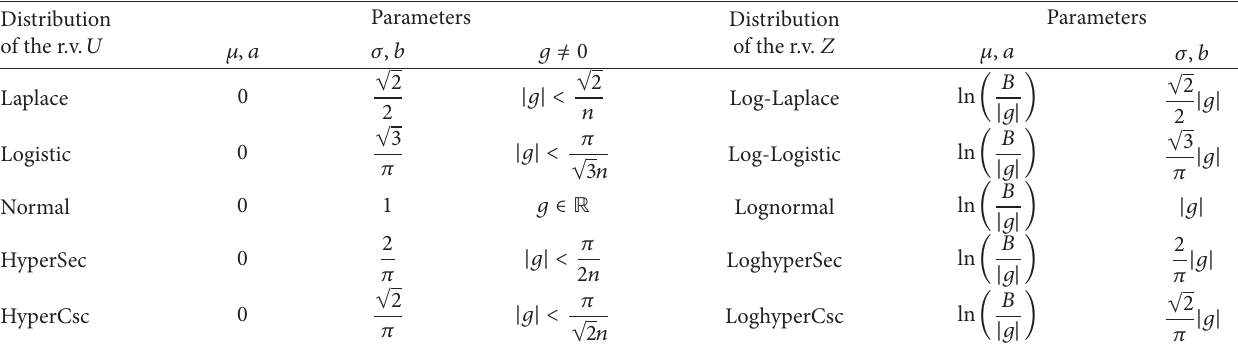
Table 1: Parameters of the pdf of the random variable 𝑍 = ln (𝑋) .